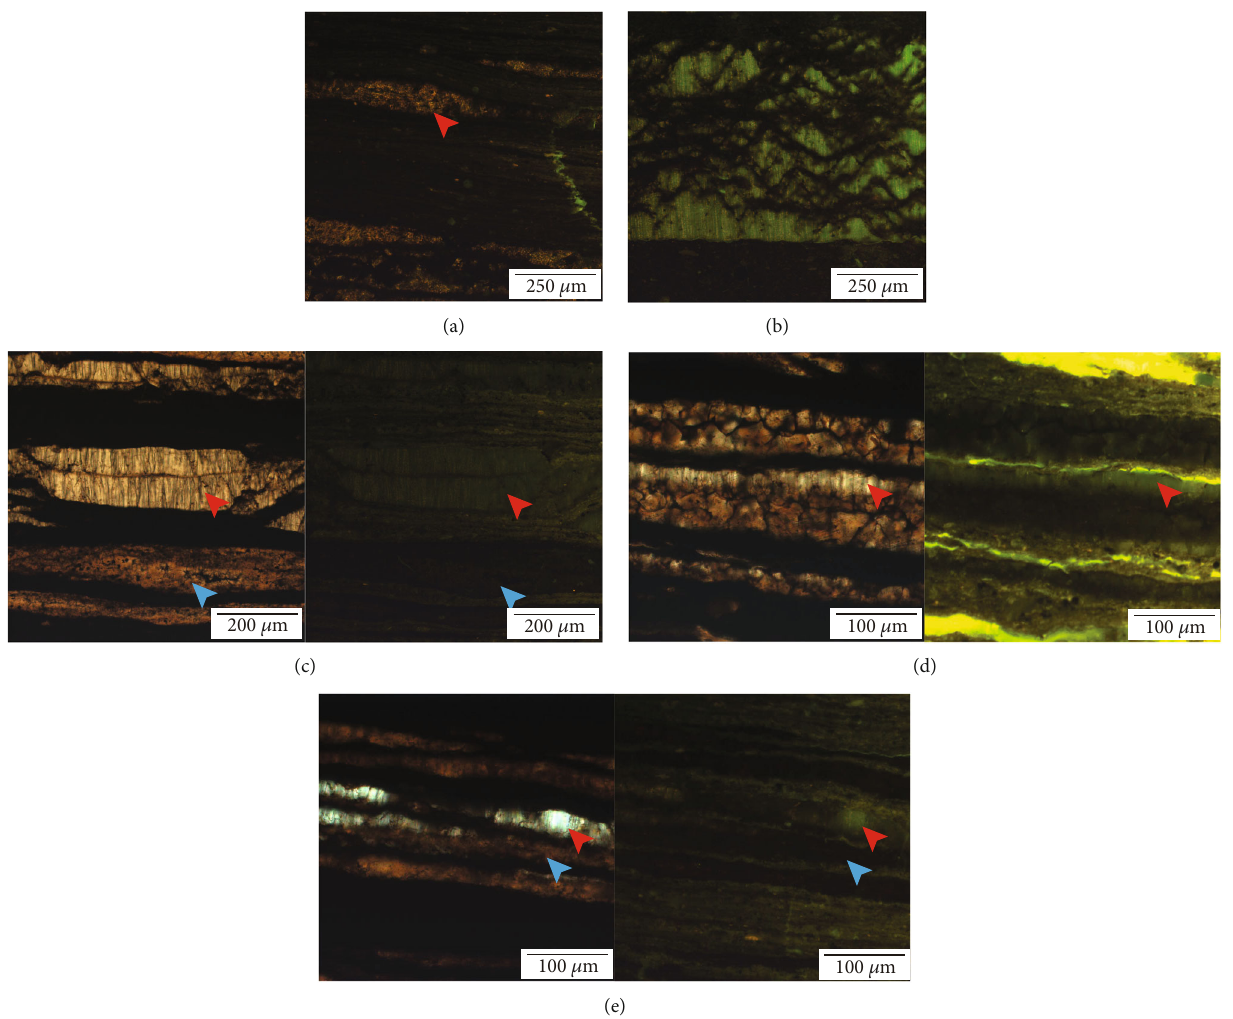
Figure 8: Calcite veins observed under the fl uorescence microscope. (a) FY1, 3418.35m: blocky calcite crystals with weak fl uorescence (red arrow). (b) FY1, 3197.27m: fi brous calcite crystals had the most obvious green fl uorescence. (c) FY1, 3418.35 m: fi brous calcite veins are fl uorescent (red arrow), and coarse-grained calcite veins are not (blue arrow). (d) NY1, 3458.57 m: blocky crystals in the median zone of the antitaxial calcite veins are less fl uorescent than the fi brous calcite with which it coexists and which has greenish fl uorescence (red arrow). (e) FY1, 3438.52m: the sample is similar to sample (d). The micritic carbonate of the median zone is not fl uorescent (blue arrow), which is in contrast to the fl uorescence of the fi brous calcite (red